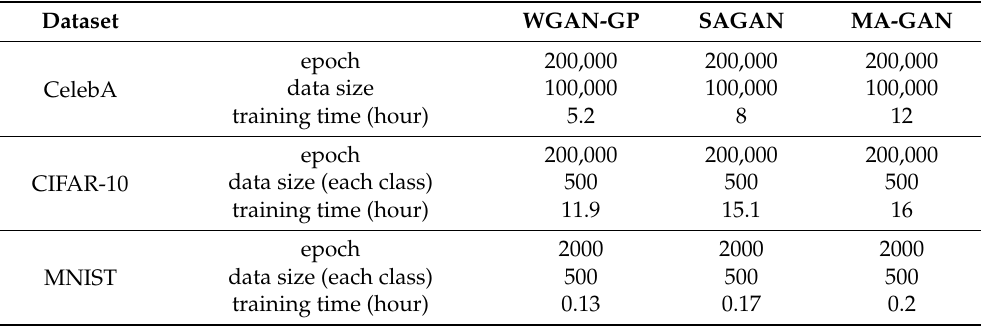
Table 14. Computational cost comparison of the